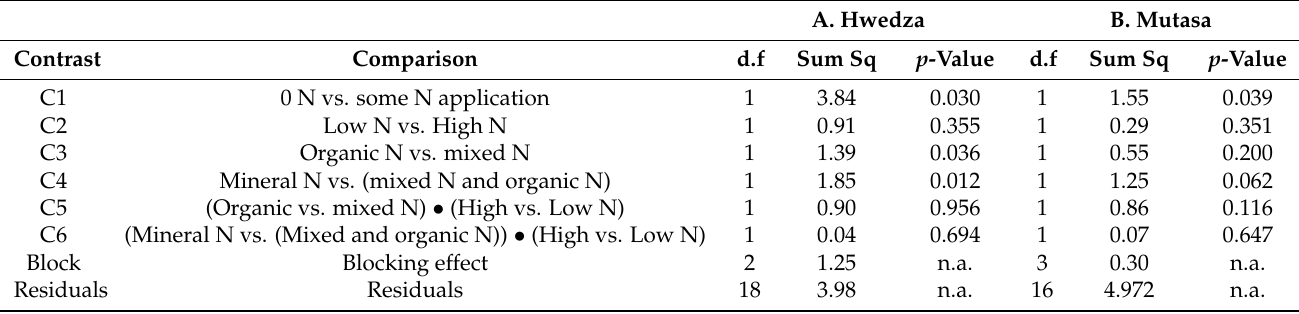
Table 6. ANOVA contrasts showing effects of different N management strategies on maize grain yields in Hwedza and Mutasa.